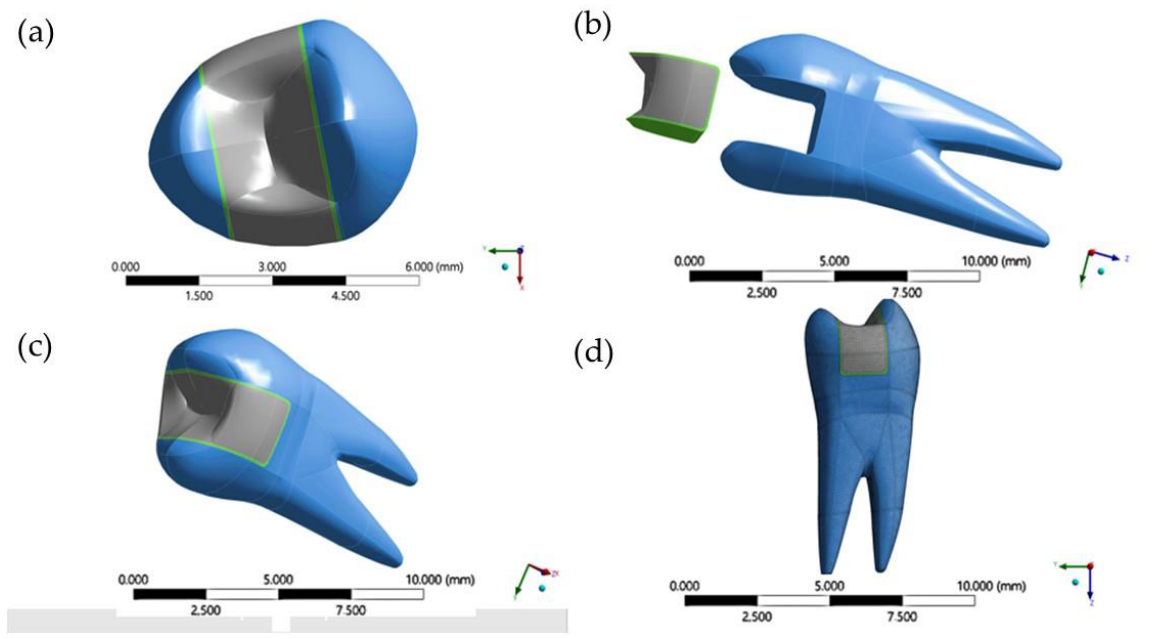
Figure 1. Finite element model showing: ( a ) coronal portion, restoration, and resin cement; ( b ) crown, root, prepared cavity, indirect composite resin restoration, and resin cement; ( c ) simulation of cemented indirect composite resin; ( d ) mesh obtained through the modeling software.